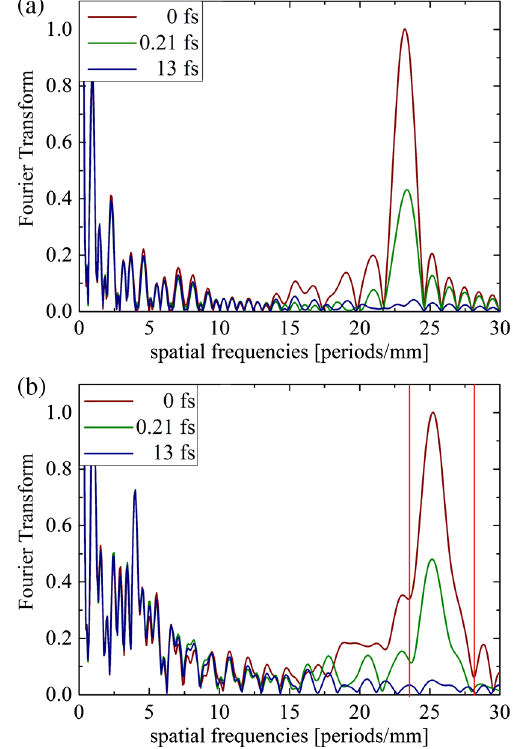
FIG. 9. Normalized FT for ideal mirrors (a) and for nonperfect mirrors (b). The red vertical lines in Fig. (b) mark the area that is integrated in order to evaluate the temporal coherence. show the typical characteristics of the temporal coherence properties of SASE pulses. A narrow peak that can be approximated with a Gaussian function assuming a con- stant background of V ¼ 0 . 2 appears on short time scales